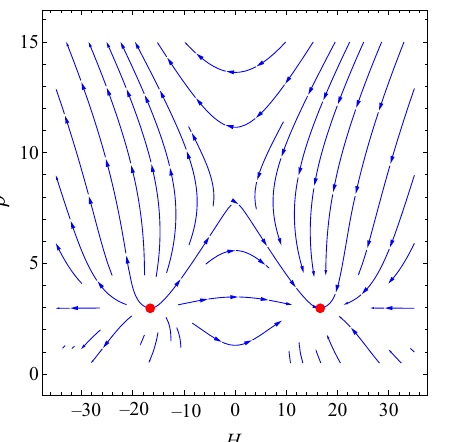
numericalvalues: μ 0 = 1, ρ ∗ = 3 , ω = − 0 . 95 , (cid:3) ∗ m ∈ ( 0 . 2 , 0 . 5 ) , c 2 s ∈ ( 0 , 0 . 5 ] and C , D > 0.Rightpanelisinthepresenceofminimumlength with the same numerical values except μ 0 = − 1 , ρ ∗ = 6